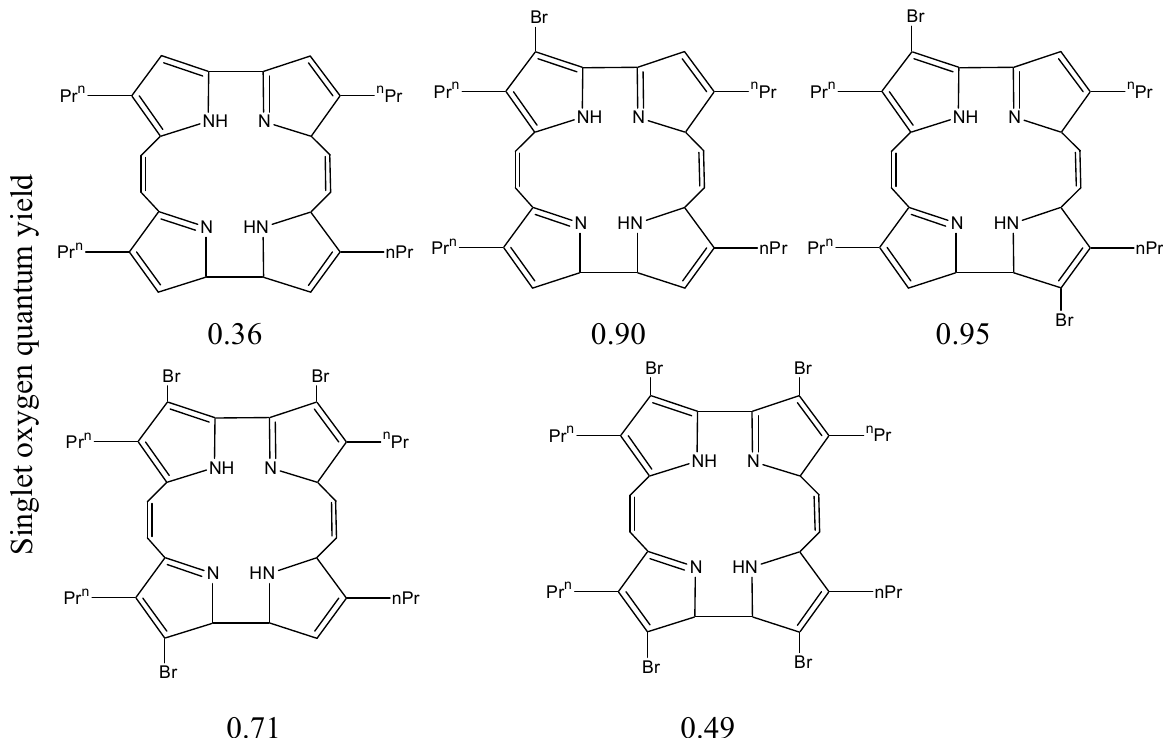
Figure 22. Brominated porphycene macrocycles and their 1 O 2 quantum